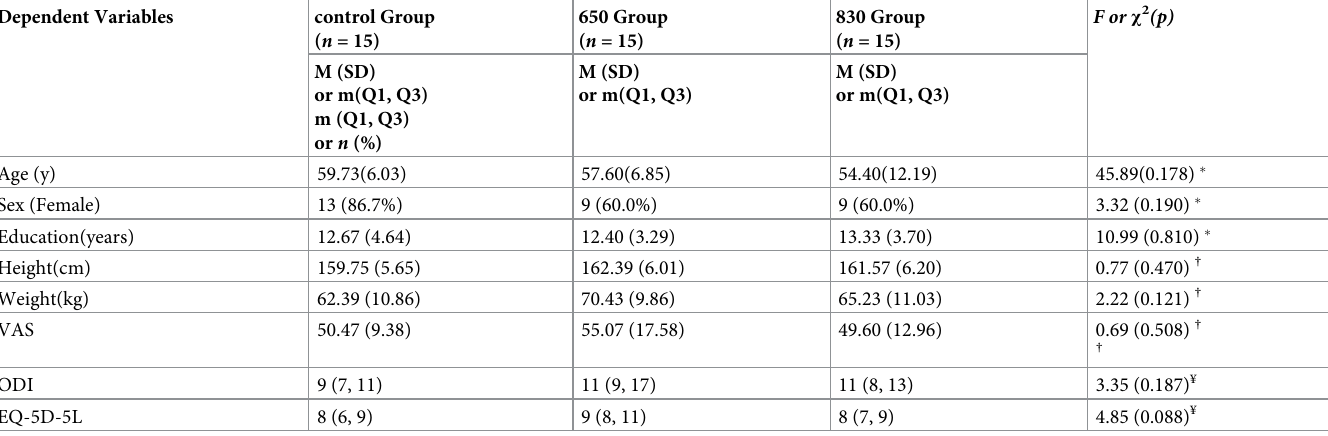
Table 2. Homogeneity tests for baseline demographic characteristics and study variables for 45 patients with chronic non-specific low back pain.